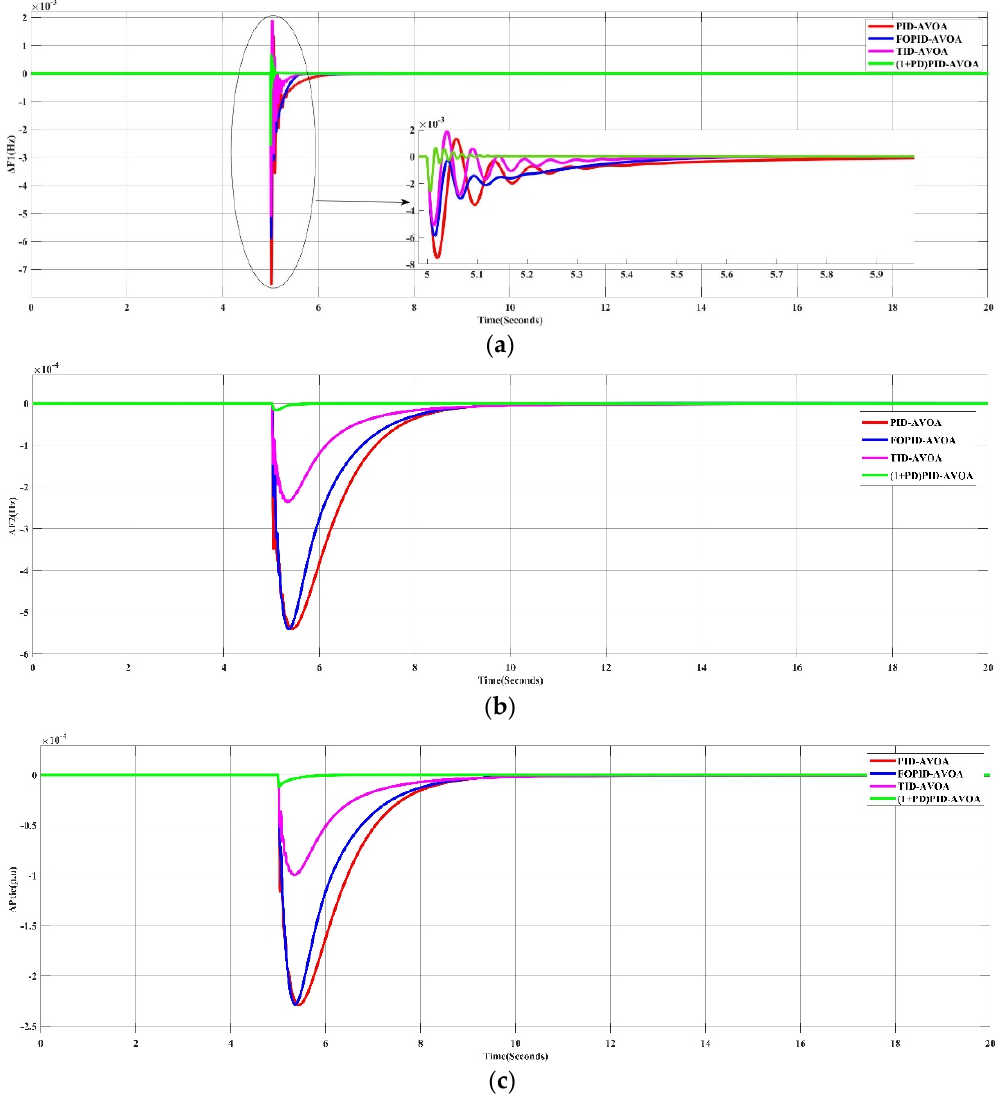
Figure 7. ( a ) The deviation of frequency in Area-1 ( Δ F 1 ); ( b ) the deviation of frequency in Area-2 ( ∆ F 2 ); ( c ) the deviation of tie-line power( ∆ P tie ) for 10% load change in